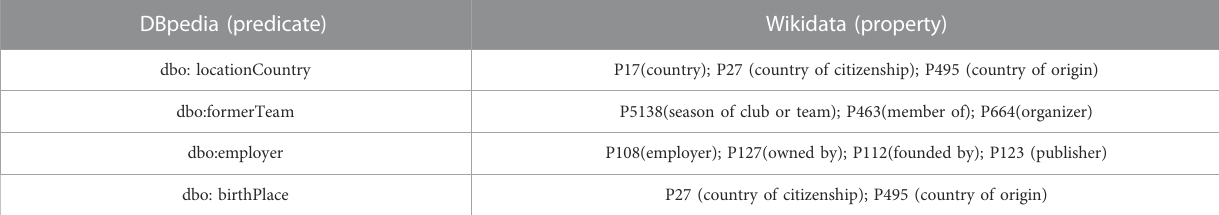
TABLE 5 Some examples overlapping type pair of